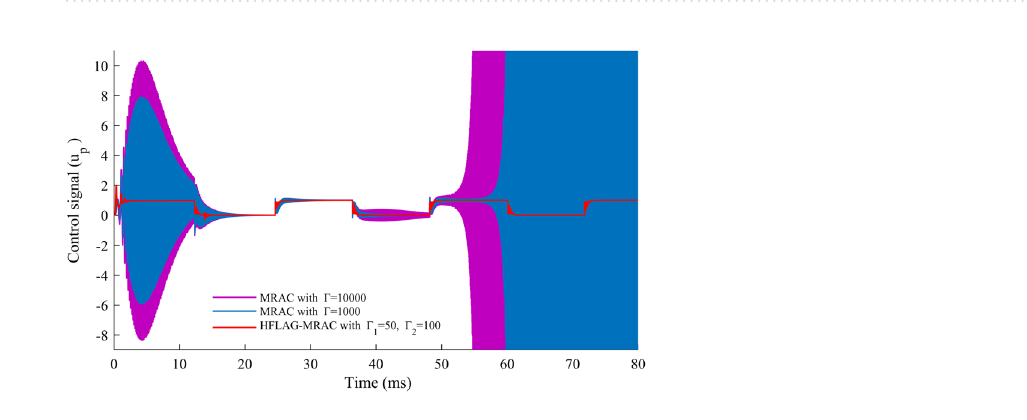
Figure 14. ( a ) Comparison of error voltage at early adaptation stage, ( b ) Comparison of error voltage at later adaptation stage.